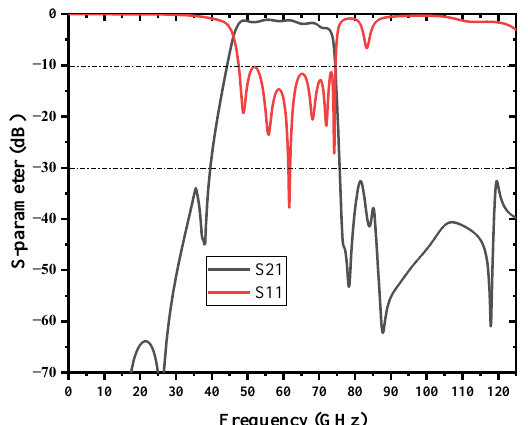
Figure 12. Simulation result of the bandpass filter with source-load coupling. Table 3. Performance comparisons of BPFs operating above millimeter-wave. (All the data are based on the simulation results).